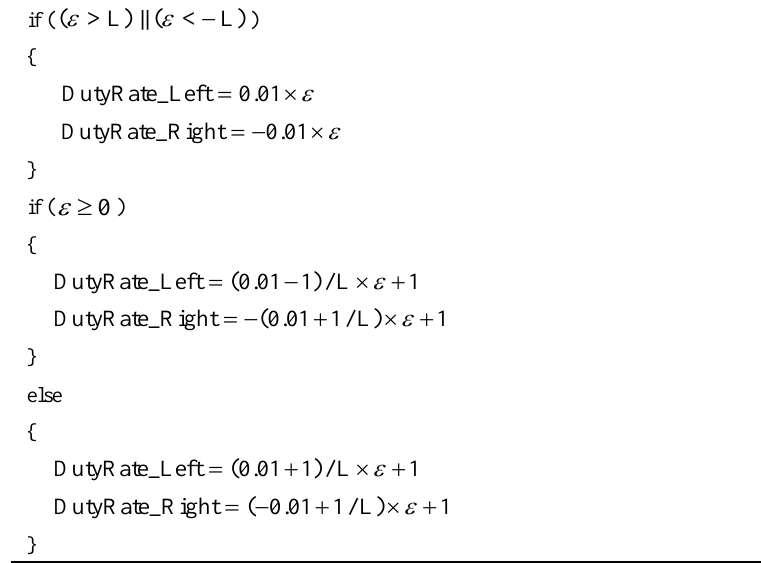
Table 2. Duty cycle mapping.